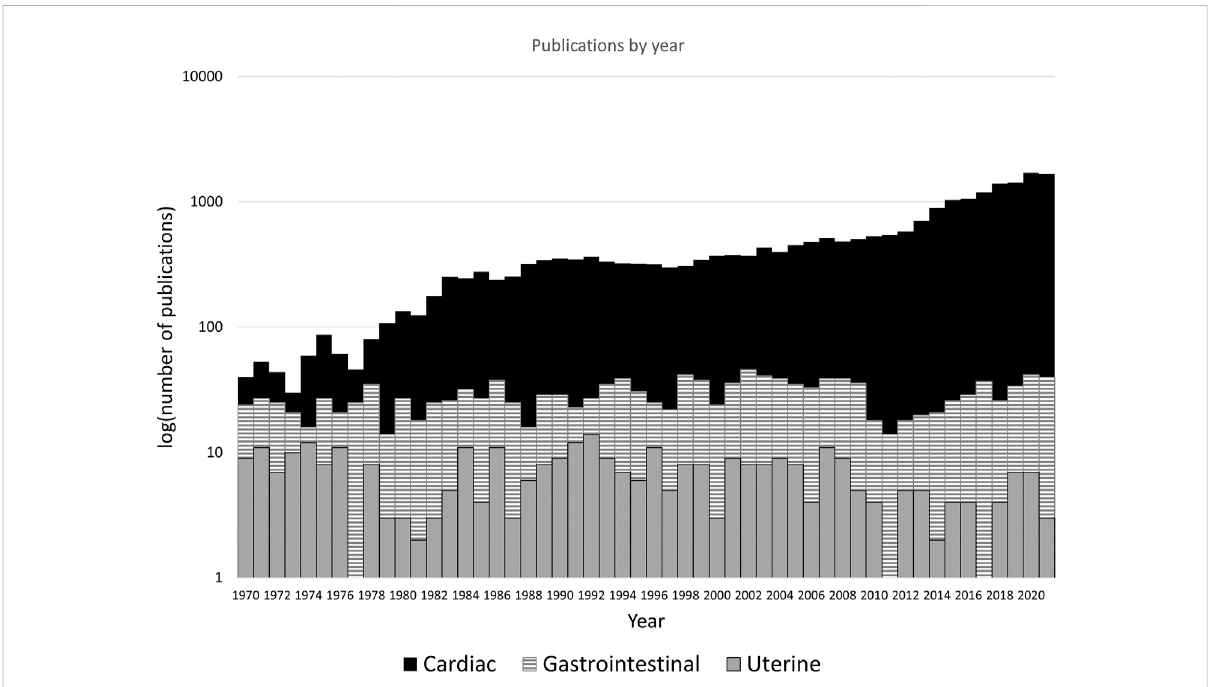
FIGURE 1 The results of a Pubmed (https://pubmed.ncbi.nlm.nih.gov/) search for “ cardiac electrophysiology ” , “ gastrointestinal electrophysiology ” and “ uterine electrophysiology ” , with variants of organ name (e.g., “ uterus ” ) included. The logarithm of the number of articles per year between1970 and 2021 are shown, as plotting number of publications rendered gastrointestinal and uterine data indistinguishable on the y -axis. Cardiac electrophysiology publications are increasing and exceeding 1,000 per year, gastrointestinal (smooth muscle organ) publications are steady at 20 – 40 per year. Publications in on uterine electrophysiology remain relatively stagnant, with < 10 per year.